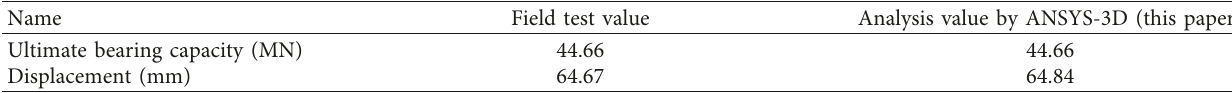
Table 3: Comparison of the results at the ultimate load.